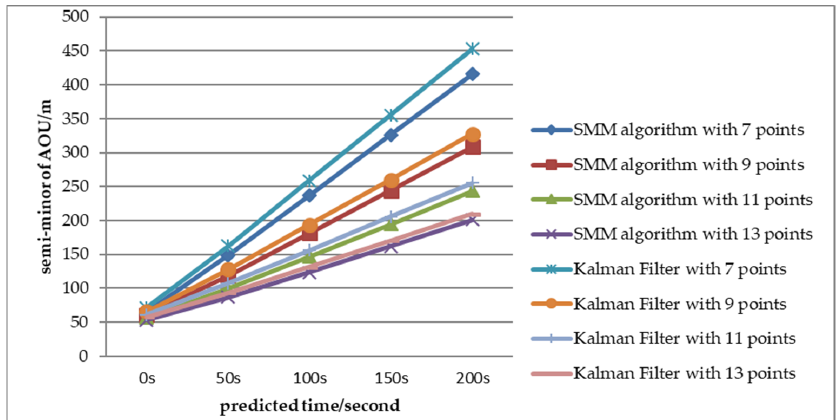
Figure 17. AOU semi-minor comparison between the SMM algorithm and the adaptive Kalman filter ( P e = P e 4 ).